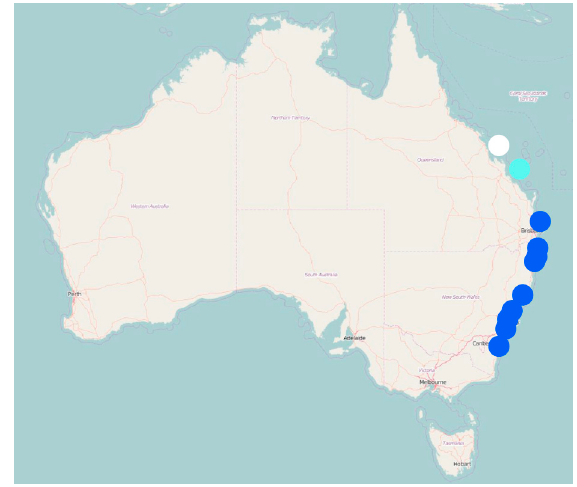
Figure 3. New distribution map for Goniobranchus splendidus . Base map taken from Online Zoological Collections of Australian Museums (OZCAM) [20] blue circles show records from the Australian Museum and Museum Victoria. White circle shows tropical occurrence reported in this study; light blue circle shows poorly known occurrence off the southern Great Barrier Reef (GBR).